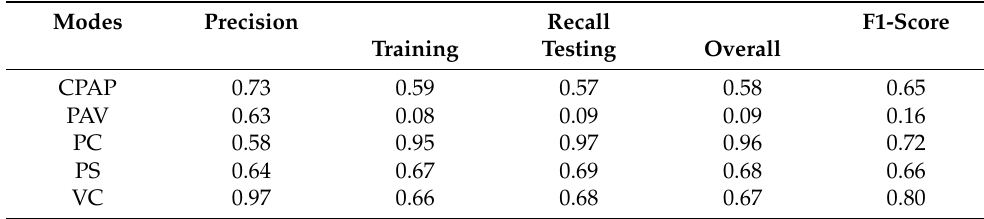
Table 10. Model evaluation report for SVM algorithm.